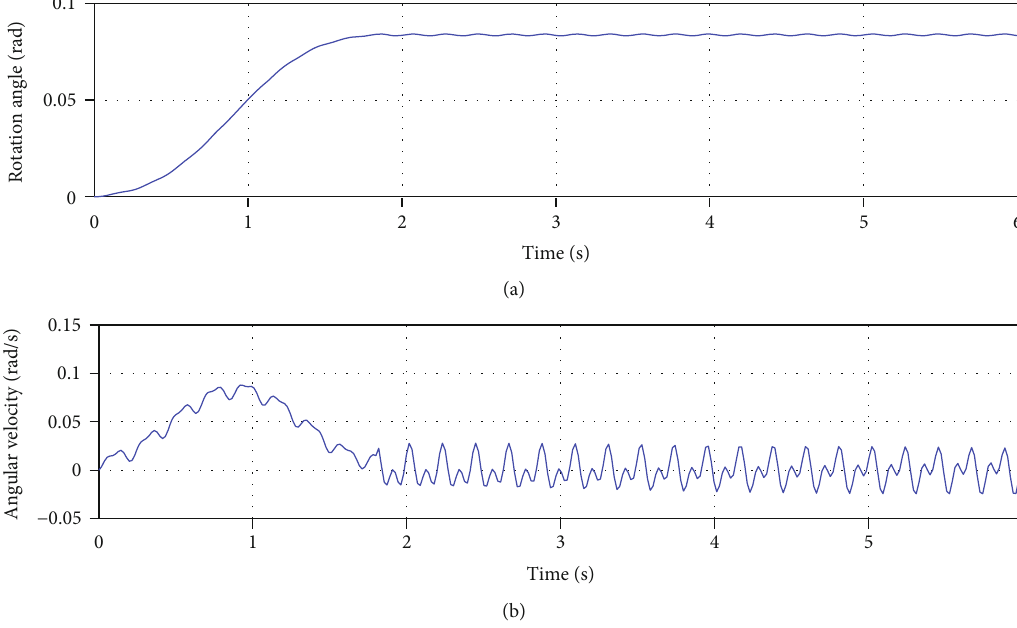
Figure 4: Response signals of rotation angle δθ and angular velocity δ _ θ at the working